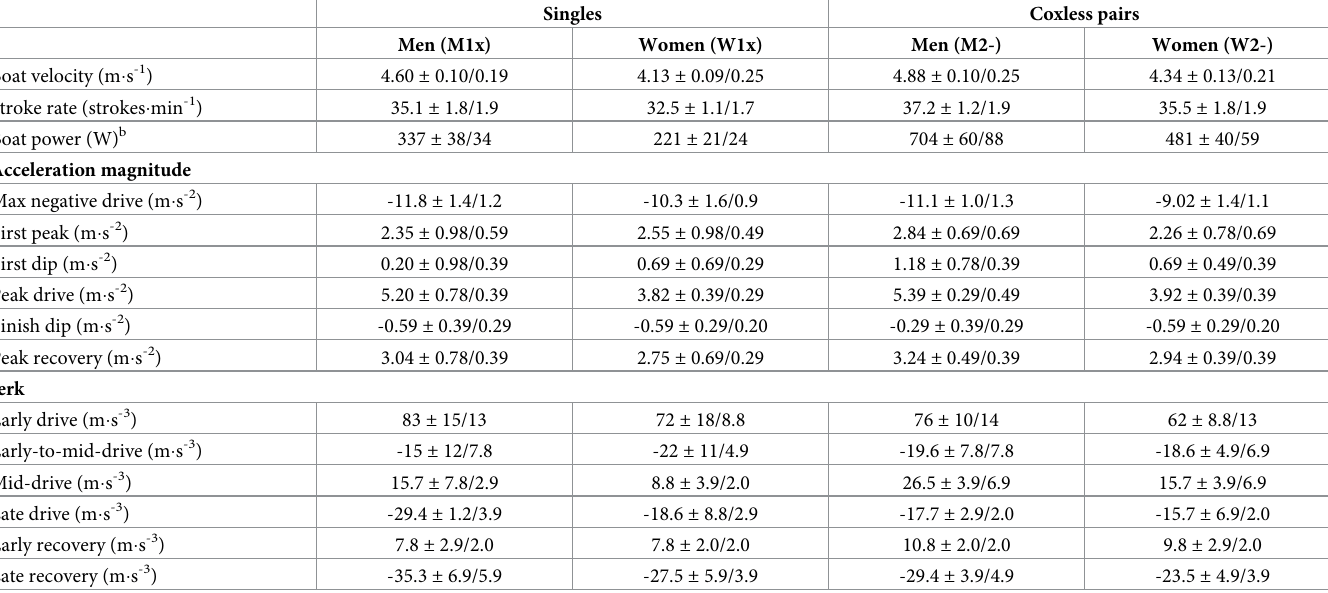
Table 1. Characteristics of boat velocity, stroke rate, and power, and the predictor variables in the four boat